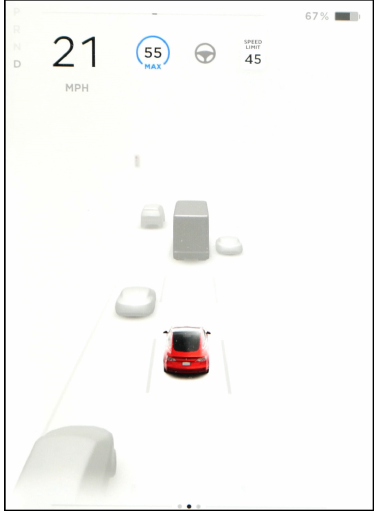
Figure 2. Example Tesla HMI design.